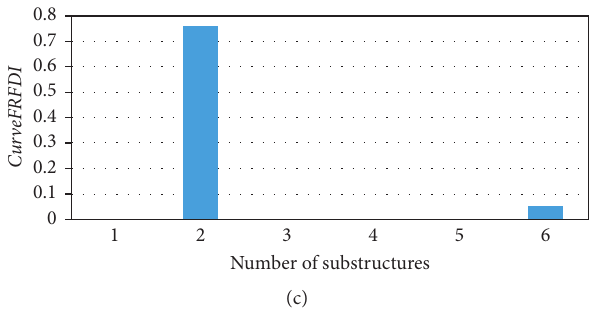
Figure 17: CurveFRFDI values for (a) case Dam_2F&4F15%, (b) case Dam_3F&5F15%, and (c) case Dam_2F&3F15%.